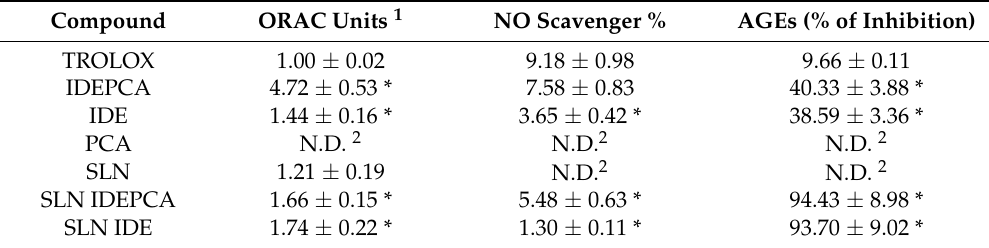
Table 5. Oxygen radical absorbance capacity (ORAC) activity, NO scavenger percentage and anti-glycation activity (AGEs) of Trolox, idebenone (IDE) and idebenone ester with pyroglutamic acid (IDEPCA), free or loaded into solid lipid nanoparticles (SLN) and pyroglutamic acid